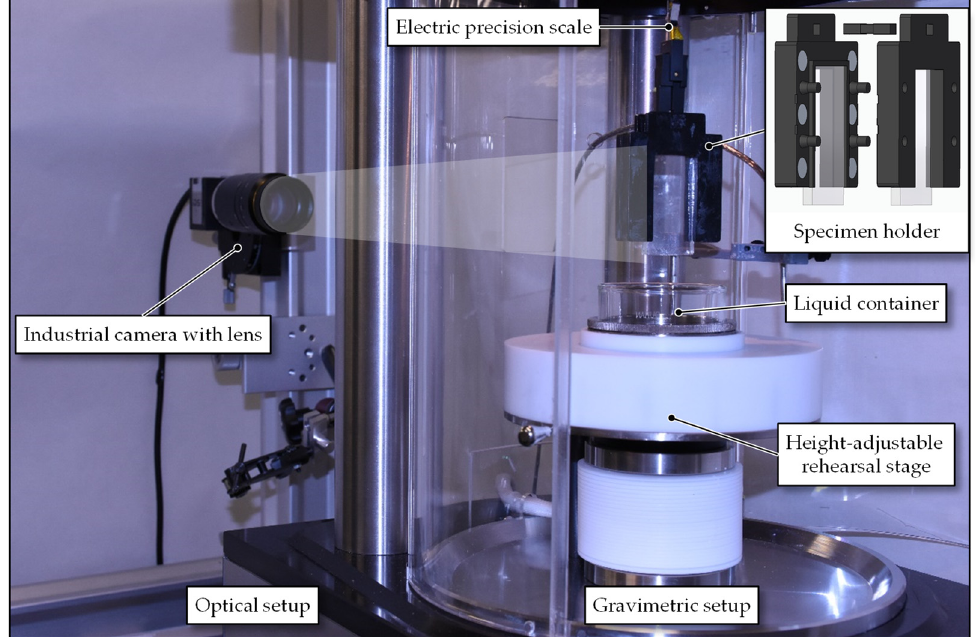
Figure 1. Illustration of the experimental setup of experiments VR1 and VR2. Camera of the optical measurement (VR2) on the left and the tensiometer of the gravimetric measurement (VR1) on the right. On the top right is a rendered detailed representation of the sample holder.